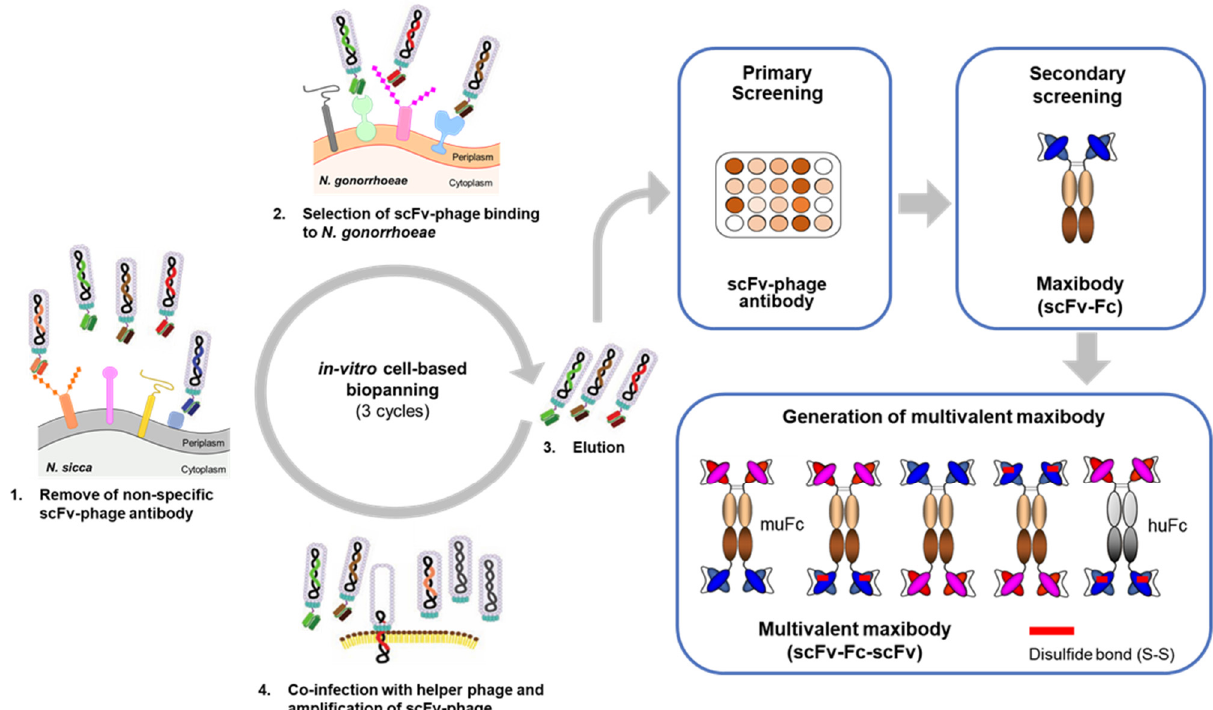
Figure 1. Overview of bio-panning and isolation of Neisseria gonorrhoeae specific antibodies. ( Left ) Selection of N. gonorrhoeae - specific antibody via in-vitro cell-based bio-panning using phage display technique: Step 1, depletion of the scFv-phage Ab library with N. sicca to remove gonorrhea-unrelated scFv-phage antibodies; Step 2, incubation of the depleted scFv-phage Ab library with N. gonorrhoeae ; Step 3, elution of N. gonorrhoeae -bound scFv-phage after removing the unbound scFv-phage antibodies; Step 4, recovery and amplification of N. gonorrhoeae scFv-phage antibodies using helper phage in E. coli TG1. ( Right ) After three rounds of bio-panning, individual scFv-phage antibodies were preliminarily screened by phage ELISA. The selected scFv-phage antibodies were converted to maxibody and multivalent maxibody and analyzed to identify the optimal N. gonorrhoeae -specific maxibody pair for diagnosis (see main text for